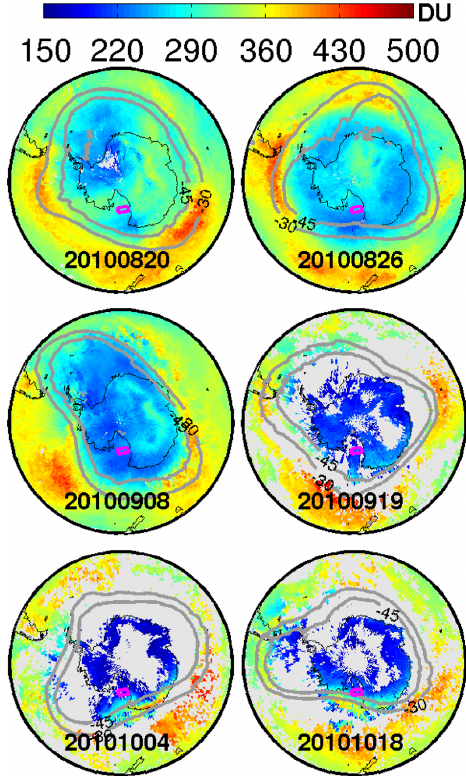
Fig. 4. The status of the vortex and position of McMurdo Sta- tion during selected days of the Concordiasi campaign. Ozone total columns retrieved from IASI measurements are in the background. The overlaid grey lines represent − 30 and − 45PVU, the approxi- mate boundaries of the vortex. The station remained inside the vor- tex during the campaign period. Starting from 15 September, the number of IASI data around McMurdo has strongly decreased due to a major change in the Eumetsat temperature retrieval processing.